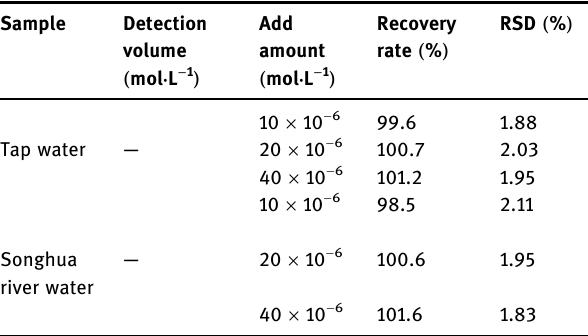
Table 1: Sample determination experiment ( n = 6